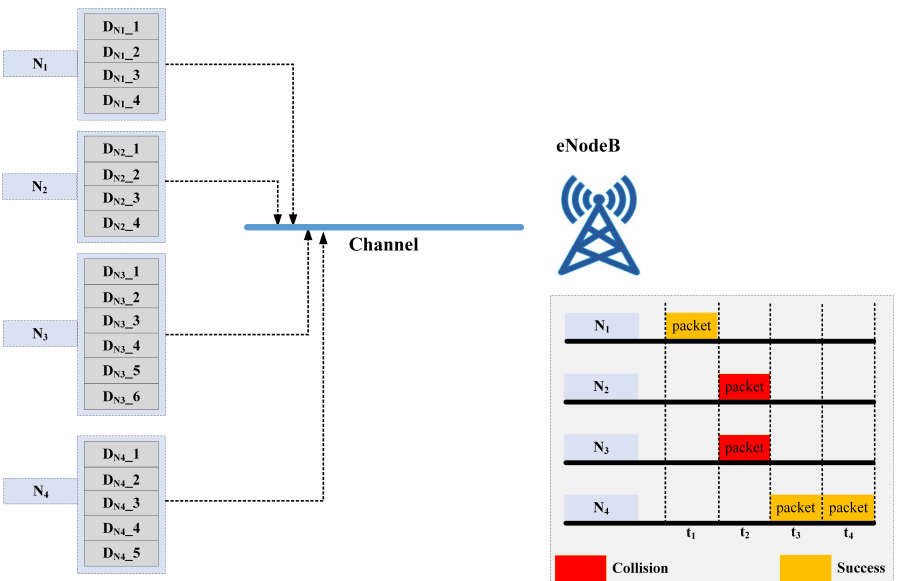
Figure 4. System model: Multiple devices transmission on single